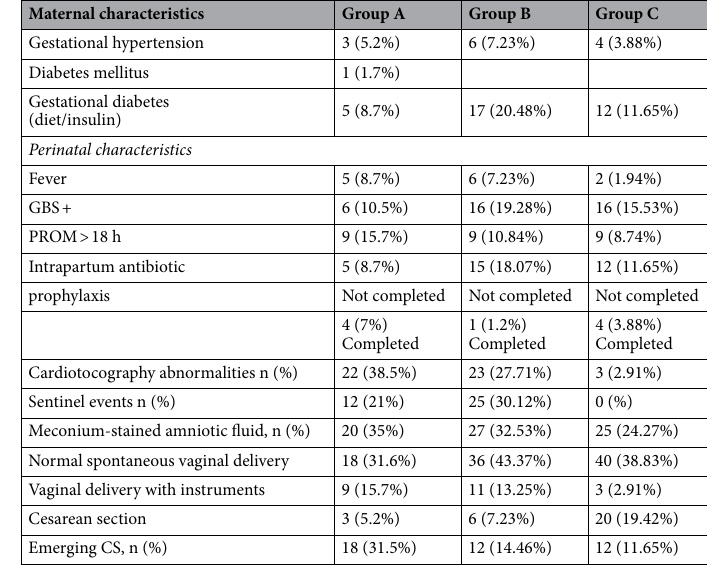
Table 2. Maternal and perinatal characteristics of the study population.